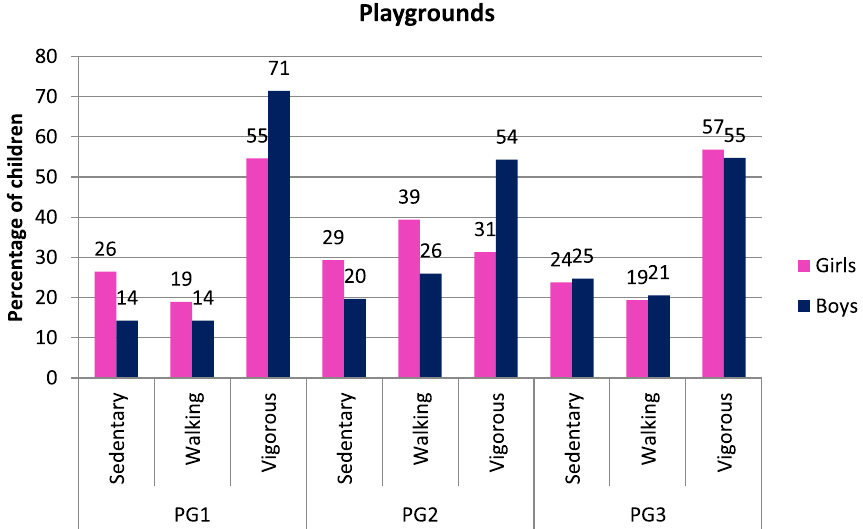
Fig. 8 Physical activity levels of children in